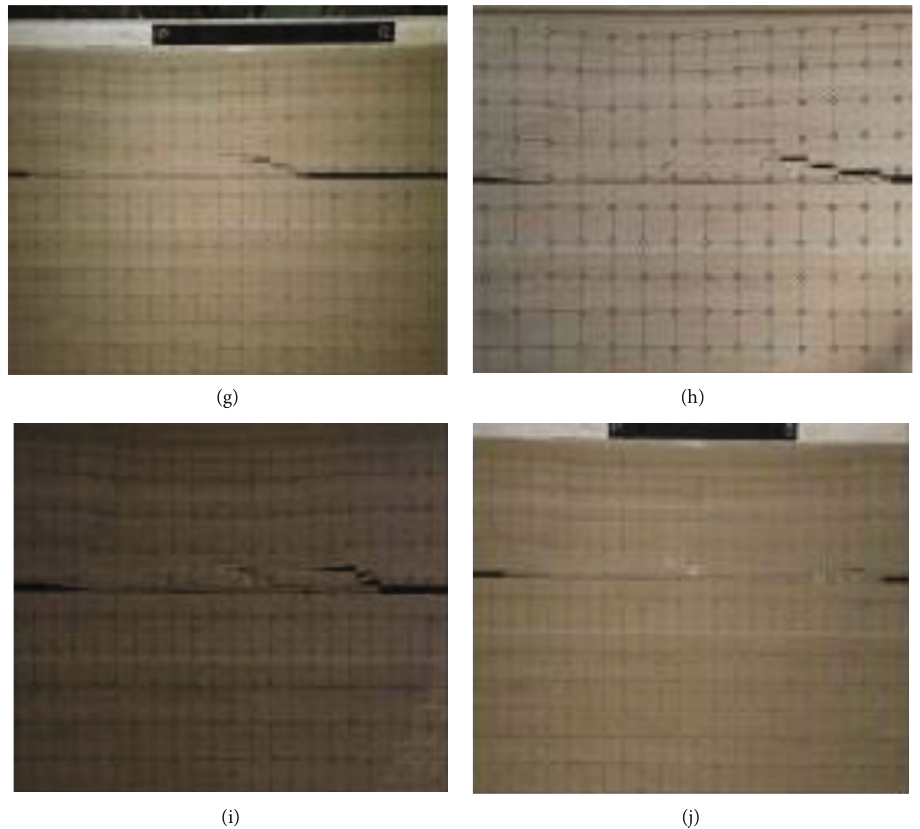
Figure 9: Caving and fracture development of the surrounding rock in the W coal mine as the working face advances to (a) 32 m, (b) 52 m, (c) 68m, (d) 78m, (e) 98m, (f) 110m, (g) 118m, (h) 128 m, (i) 168m, or (j)